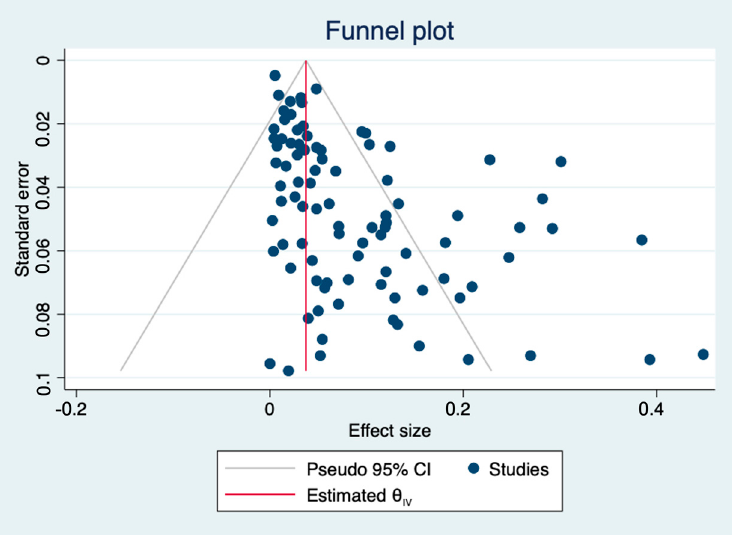
Figure 2. Funnel plot of the association between estimated effect sizes and standard errors in a single study of prevalence. ( θ IV : summary estimate).